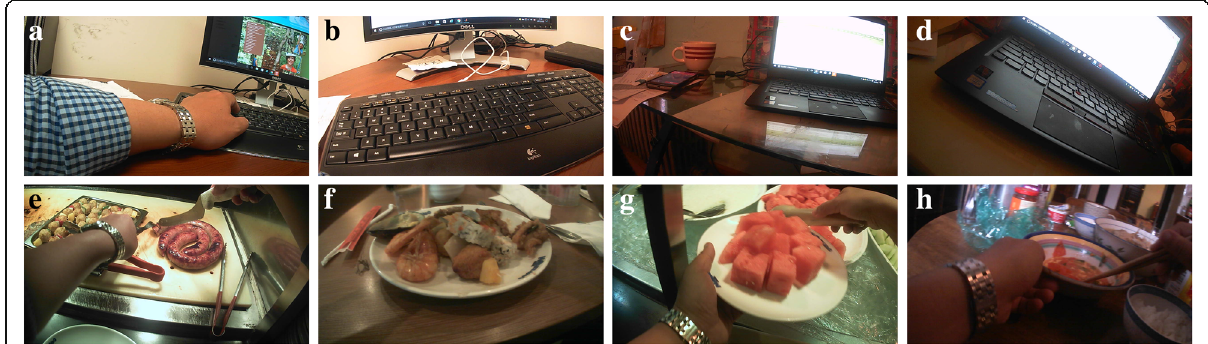
Fig. 3 Examples of egocentric images of different activities. a – d are the egocentric images of “ computer use ” ; e – h are the egocentric images of “ eating